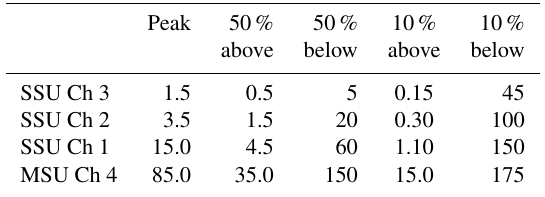
Table 2. Pressure (hPa) of SSU channels 1, 2, and 3 and MSU chan- nel 4 weighting function peaks, 50% of peak weight above, 50% of peak weight below, 10% of peak weight above, and 10% of peak weight below the peak.